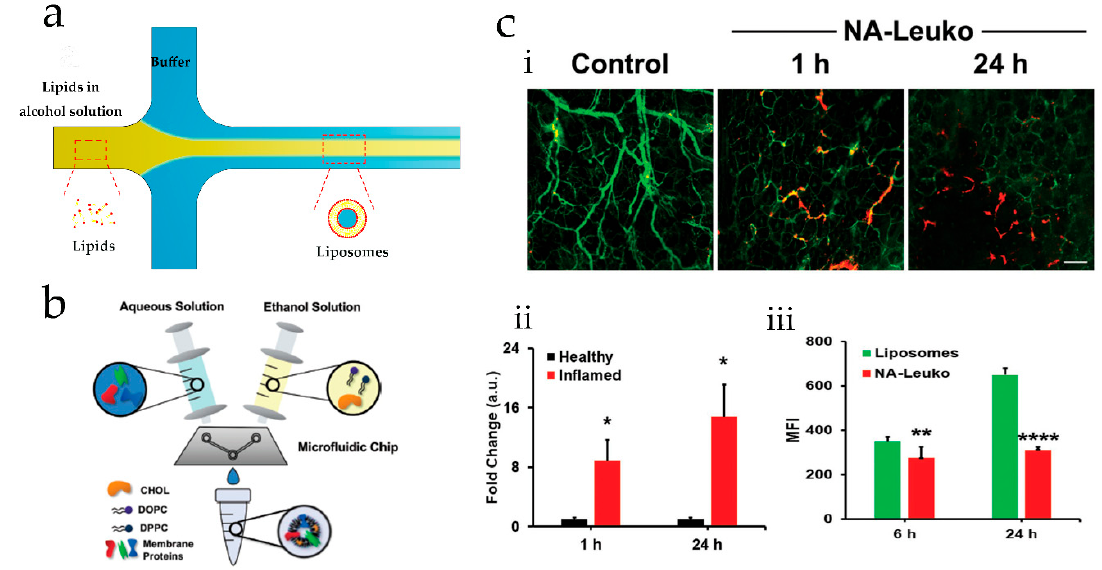
Figure 1. Microfluidic hydrodynamic focusing (MHF) methods used to prepare liposomes or vesicles. ( a ) Schematic of an MHF device used to prepare liposomes; ( b , c ) Biomimetic nanovesicles were